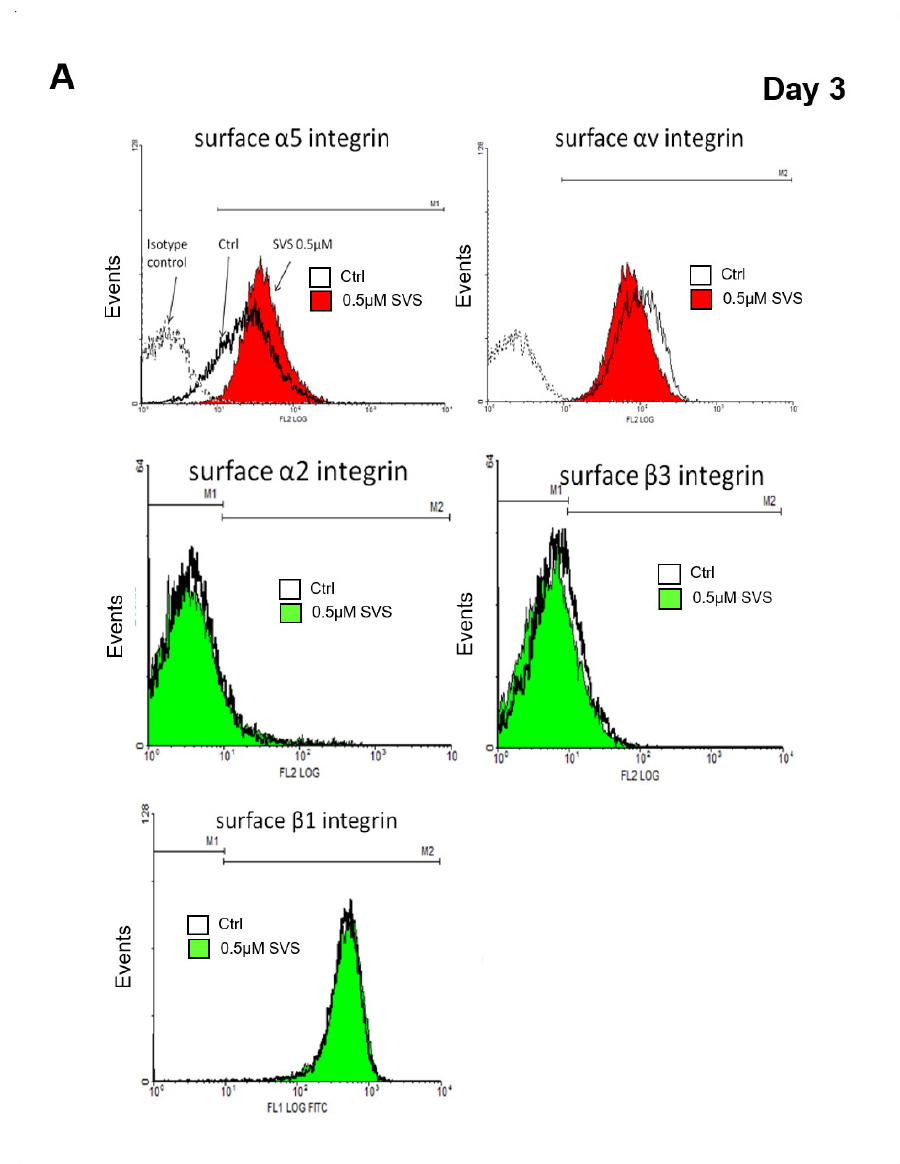
Figure 3. SVS increases the expression of α 5 integrin on the surface of D1 cells. D1 cells (passage 8) were treated with SVS in basal medium at concentrations of 0 (control: Ctrl) or 0.5 µ M for 3 days. ( A ) Cells were trypsinized and subjected to flow cytometry analysis for detecting α 5, α V, α 2, β 1, and β 3 cell surface integrins. The cells were stained with either phycoerythrin (PE)- or fluorescein isothiocyanate (FITC)-conjugated antibodies and analyzed via flow cytometry. FITC-conjugated IgG1 and PE-conjugated IgG1 of the same isotypes were used as isotype controls. ( B ) Quantification of the mean fluorescence of stained surface α 5 integrin in D1 cells treated with SVS in basal medium at concentrations of 0 (control: Ctrl) or 0.5 µ M SVS for 3 days. The expression level of surface α 5 integrin is expressed relative to the Ctrl, which is defined as 1. Data are presented as the mean ± SD ( n = 3). ** p < 0.01 in comparison to the